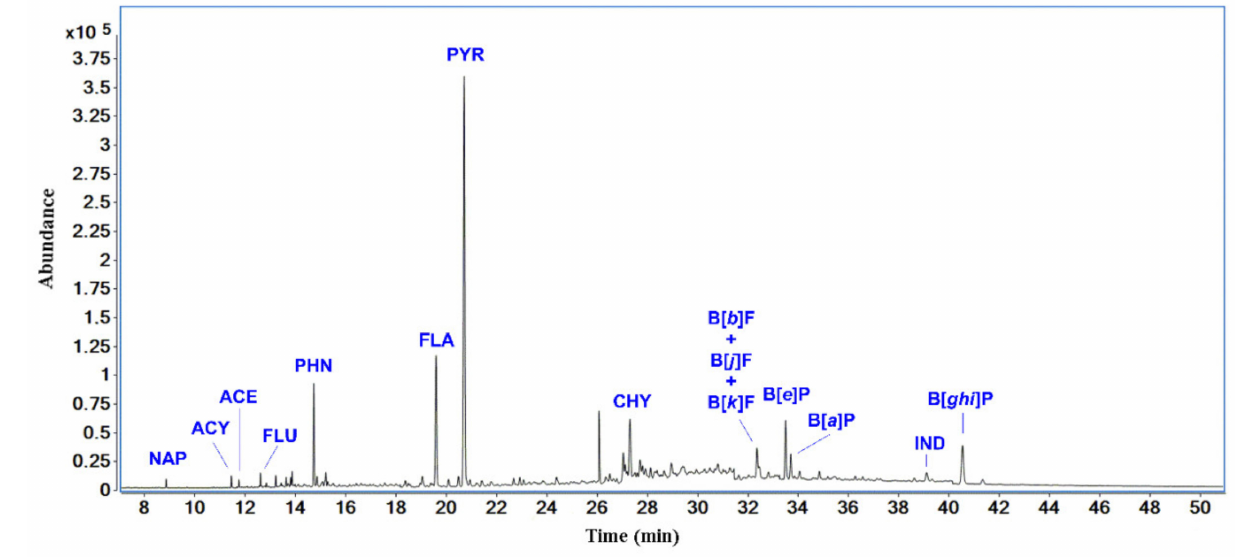
Figure 2. SIM chromatogram showing identified PAHs. Table 3. Identified PAHs in leachate from rubber